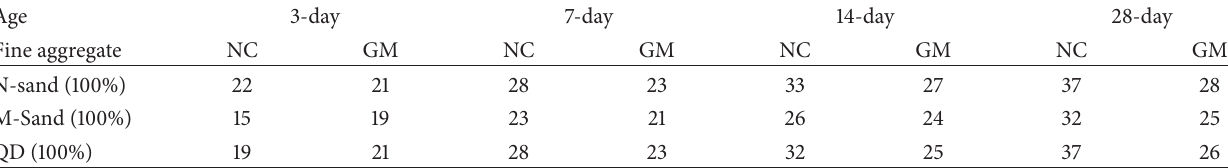
Table 7: Development of compressive strength using N-sand, M-sand, and